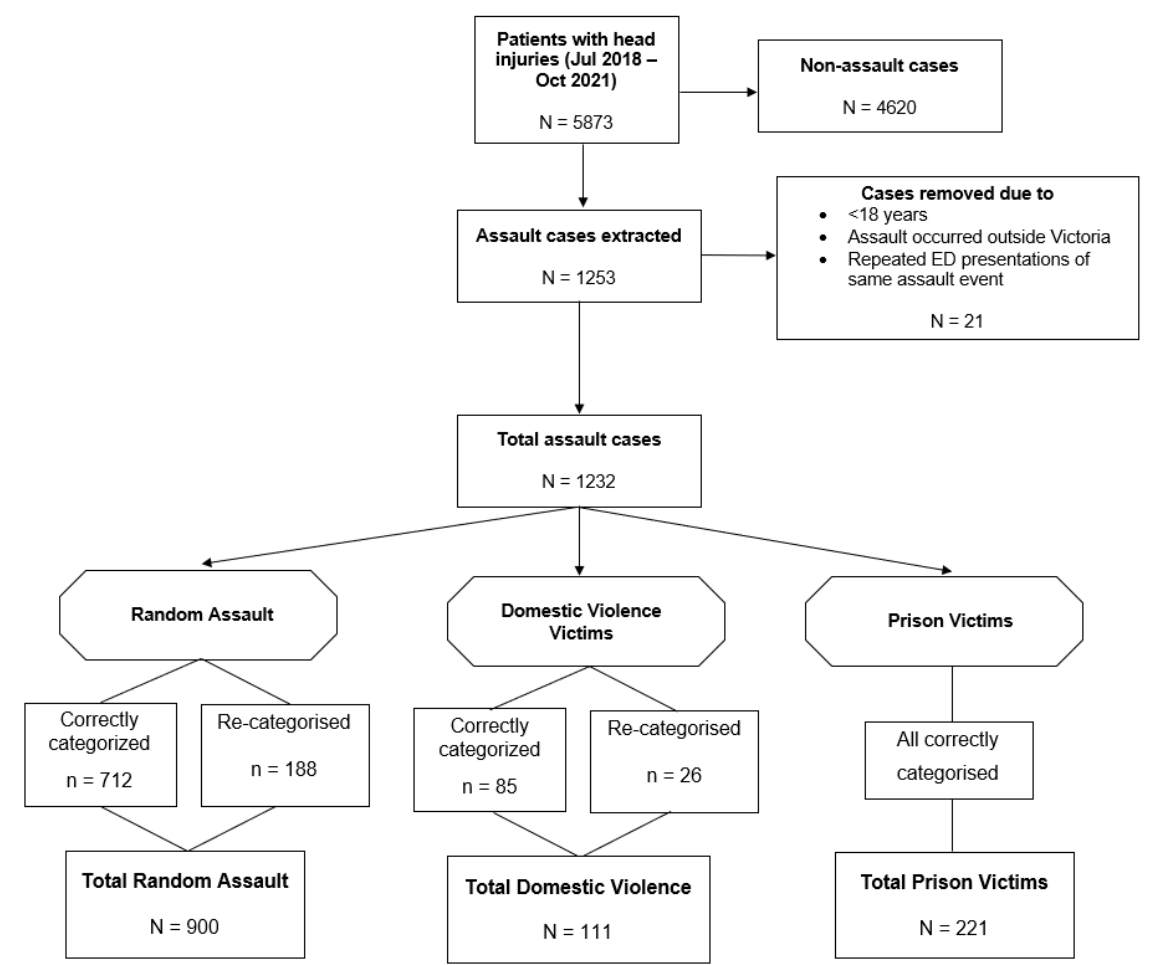
Figure 2. Flowchart of study sample selection along with inclusion and exclusion criteria.